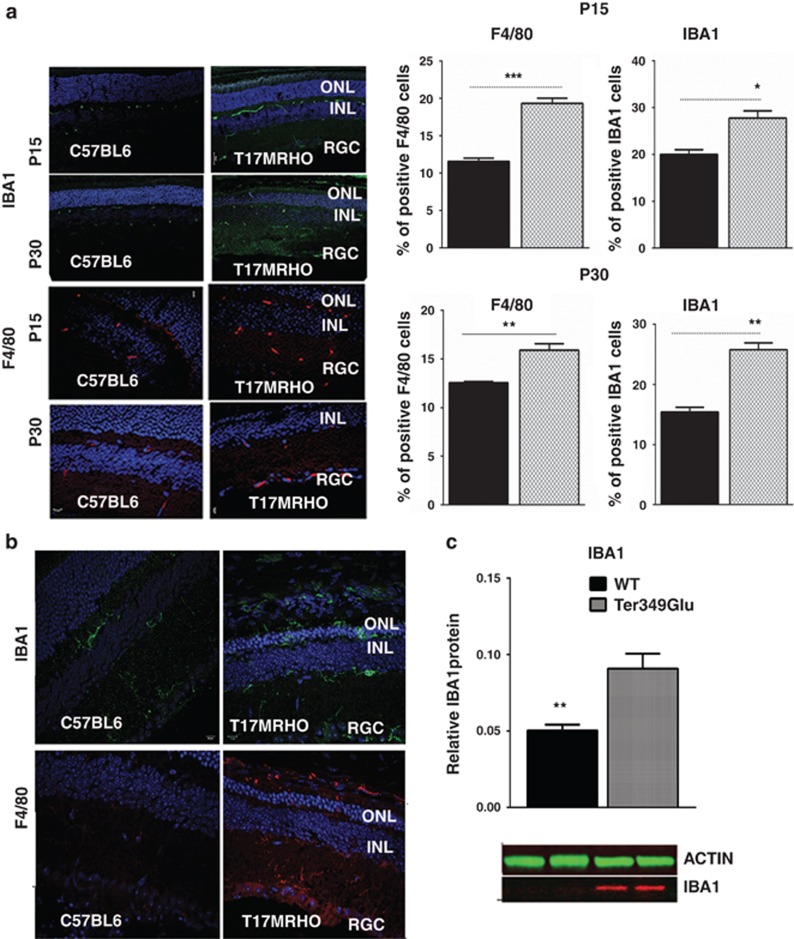
Microglia are activated during ADRP progression. (a) The microglial
markers F4/80 and IBA1 were used to perform immunohistochemical analysis
in P15 and P30 cryostat-sectioned T17M RHO retinas
(N=4). Five images of each individual T17M RHO and
C57BL6 retina were taken to count positive cells. The number of positive
cells was used to plot graphs for statistical analysis. The observed
increase in F4/80-positive cells was 67% and 26%,
respectively (P=0.01 for both time points). In addition,
there was an increase in IBA-1 positive cells during ADRP progression from
40–70% compared with controls (P=0.013 and
P=0.002, respectively). The distribution of data values
are shown in S.E.M. Representative confocal images of P15 and P30 retinas
are shown. (b) Activation of the microglial markers IBA1 and
F4/80 were found in 10-week-old Ter349Glu retinas. Representative images
are shown. (c) Almost 2-fold increase in IBA1 protein was found in
Ter349Glu retinal protein extracts, P=0.014
(N=4). Bottom: images of the western blot treated with
anti-Iba1 and anti-β-actin antibodies